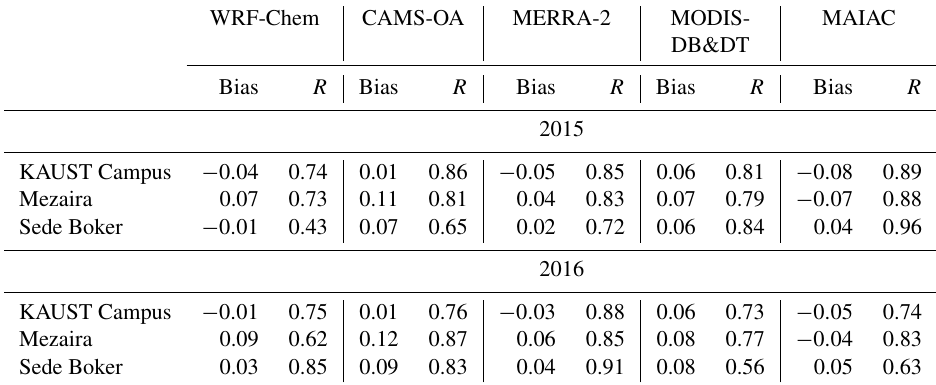
Table 4. Pearson correlation coefficient R and mean bias calculated for daily averaged AOD time series from WRF-Chem, CAMS-OA, MERRA-2, MODIS-DB&DT, and MAIAC with respect to AERONET AOD observations. WRF-Chem CAMS-OA MERRA-2 Bias R Bias